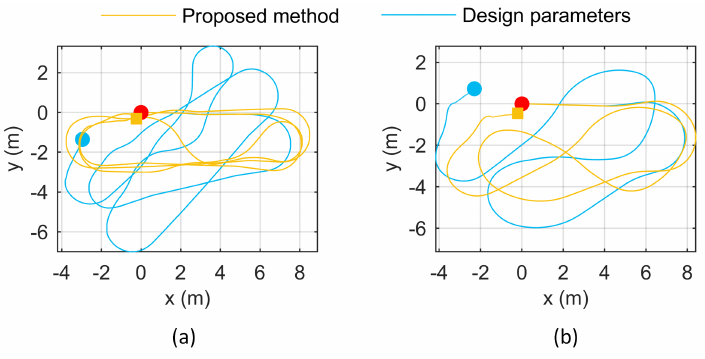
Figure 15. Odometry trajectories using design odometry parameters and calibrated odometry parameters under data ( a , b ) of Section